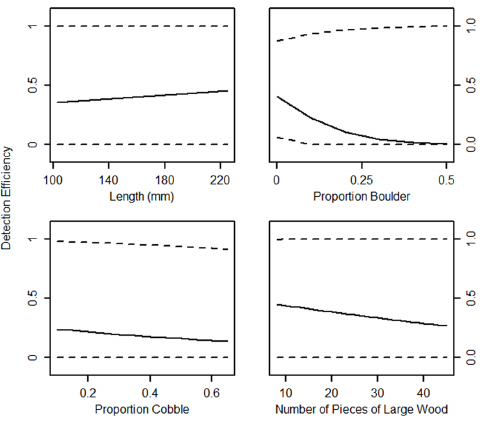
Fig 2. Model averaged estimates of portable antenna detection efficiency for PIT-tagged brown trout, bull trout, and redband trout in Leonard Creek, Brownsworth Creek, and Boulder Creek. Model averaged unconditional 95% confidence intervals for estimates are displayed as dotted